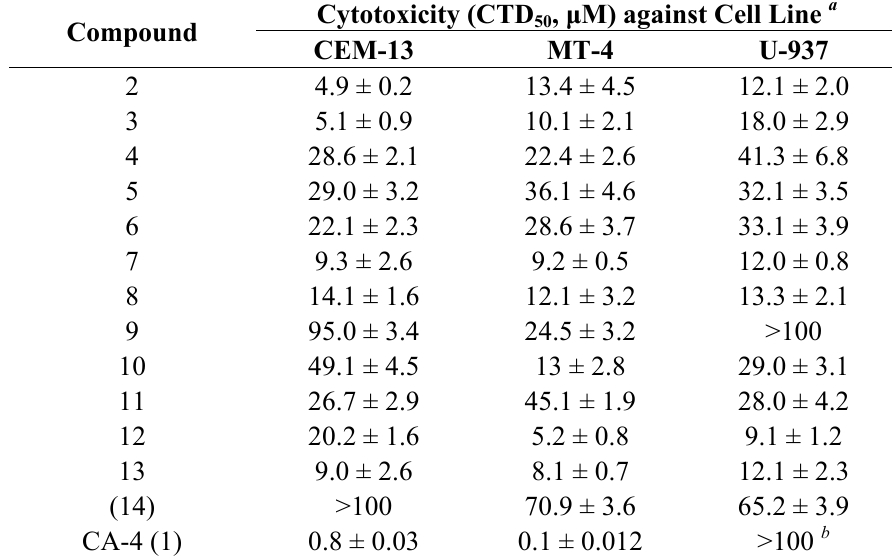
Table 1. Cytotoxic activity of heterocyclic analogs of combretastatins 2 – 13 .